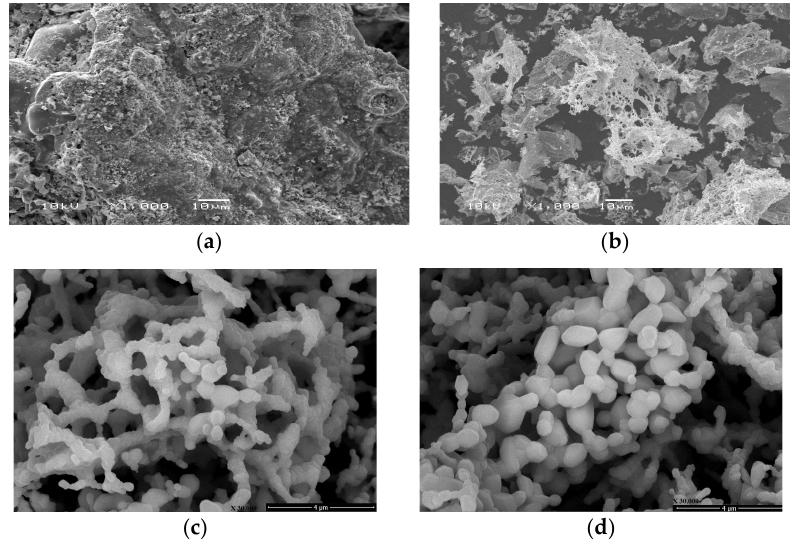
Figure 4. SEM images of the prepared samples; ( a ) S1, ( b ) S2, ( c ) S3 and ( d ) S4 samples.